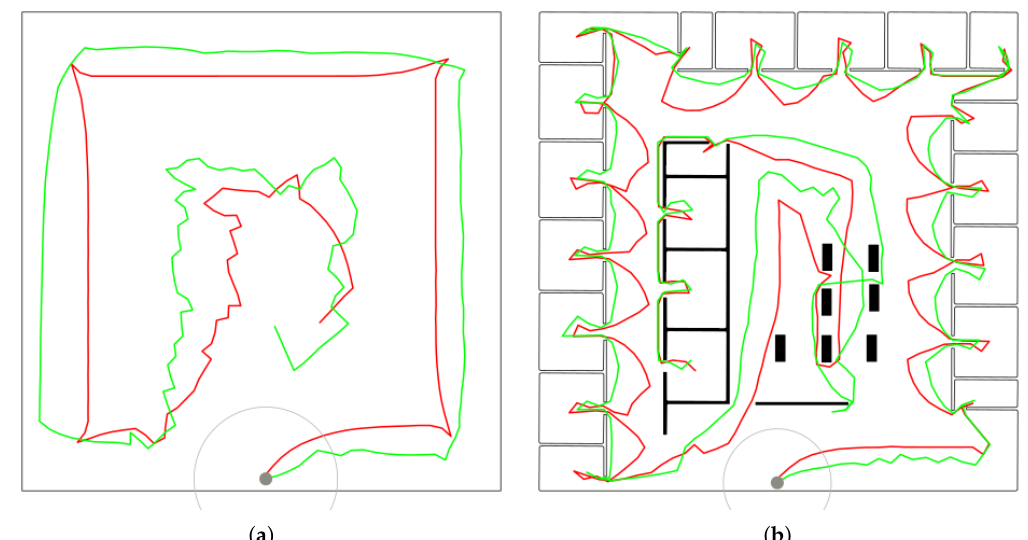
Figure 9. The best results found by EA (red) and FHP (green) on ( a ) empty with ρ = 3.0 m and ( b ) jari-huge with ρ = 2.0 m.